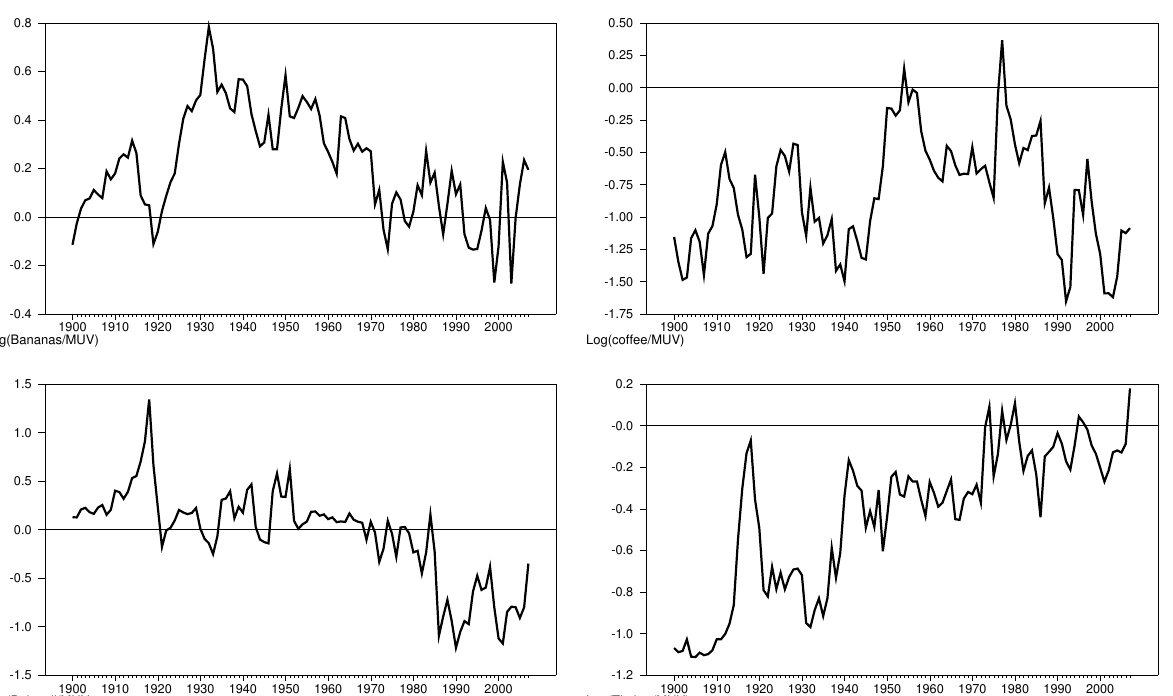
(cid:17) (cid:16) i t for every commodity price i in Group C in Table 1. MUV t